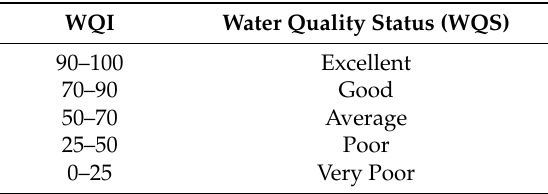
Table 1. Ranges and status of